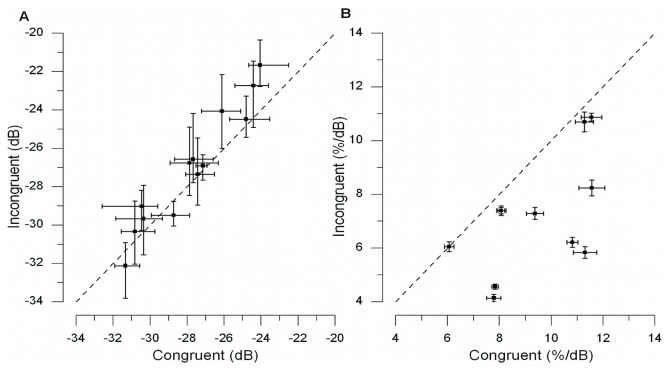
Results of experiment 1.A) Scatterplot of data from individual subjects showing the relationship between the thresholds for the congruent and incongruent condition. The dotted line depicts a linear relationship between the congruent and incongruent condition. Most subjects show a lower visual threshold for the congruent condition than for the incongruent condition. Error bars show the 95% CI for each subject's bootstrapped data. The visual contrast thresholds where converted from a linear contrast scale to a decibel (dB) scale using the following equation: Contrast (dB) = 20*log
10(Linear Contrast). B) Scatterplot of the relationship between the slopes for the congruent and incongruent condition. The dotted line depicts a linear relationship between the congruent and incongruent condition. Most subjects have a steeper psychometric curve for the congruent condition than for the incongruent condition. Error bars show the 95%-CI for each subject of the bootstrapped data.